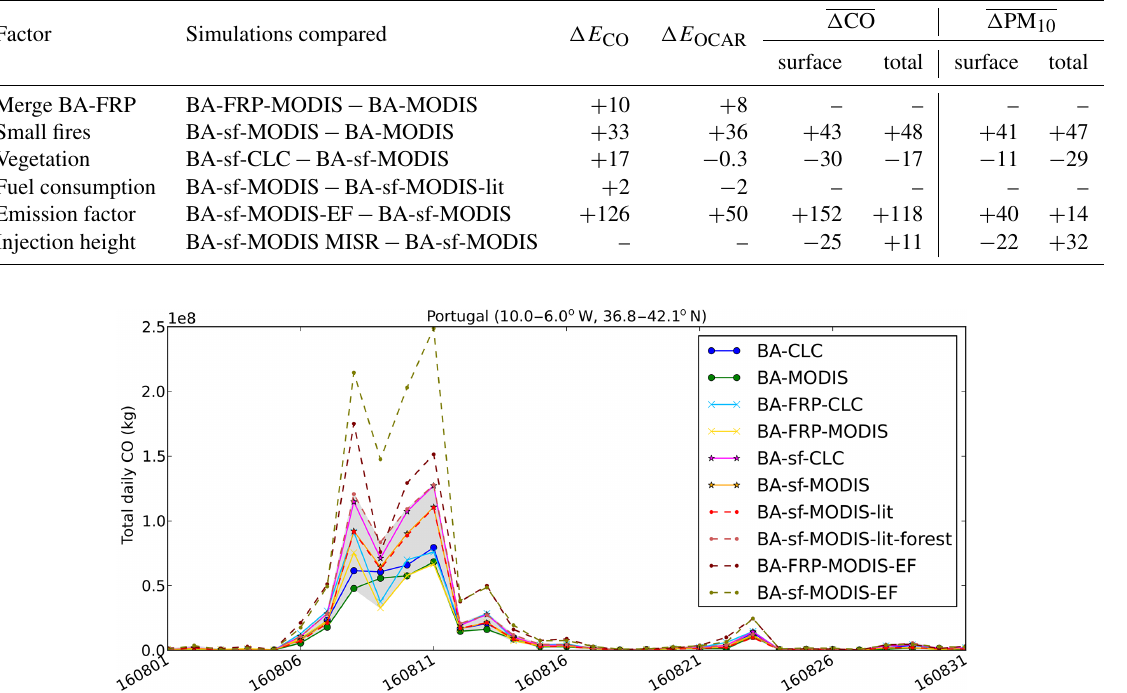
Table 3. Relative impact (%) of factors tested in the calculation of the emissions with APIFLAME on the total emissions of CO and organic carbon and on the resulting concentrations. Differences of simulated concentrations ( (cid:49) CO and (cid:49) PM 10 ) are calculated as (X test − X ref )/X ref and then averaged over points with relative impact from fires > 10%.